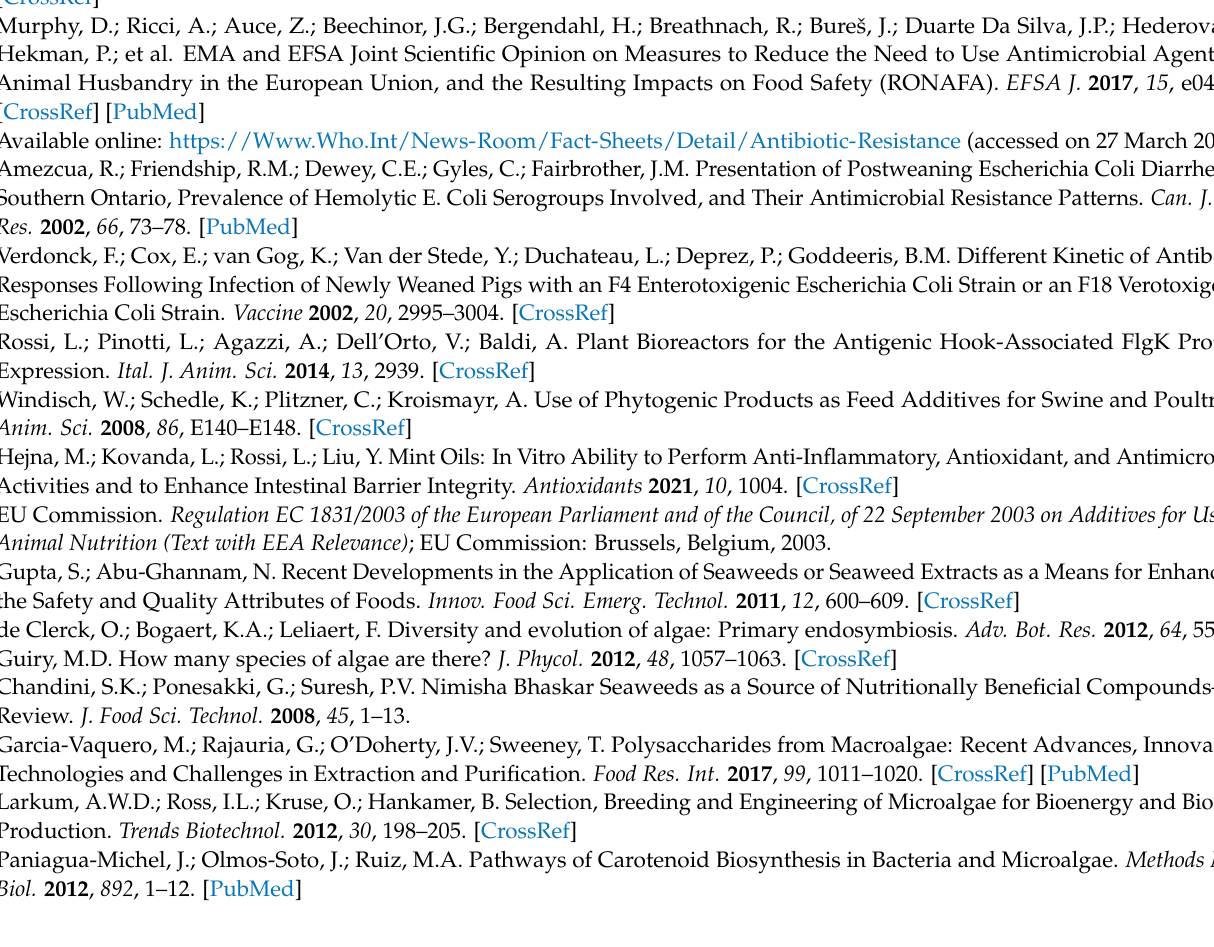
Figure S4: Antimicrobial activity of algal extracts diluted at 1:8 against E. coli ; Figure S5: Membrane integrity of intestinal IPEC-J2